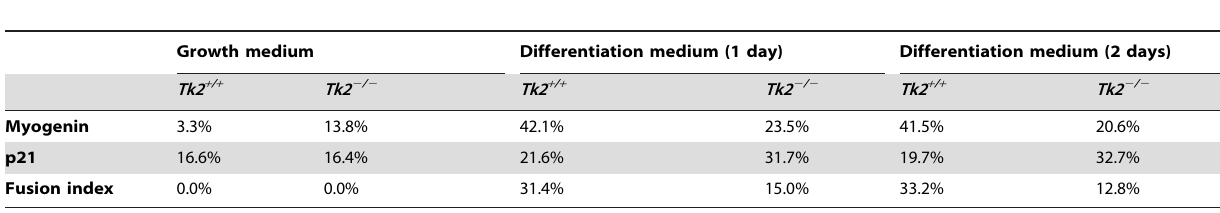
Table 3. Percentage of Tk2 + / + and Tk2 2 / 2 positive cells for myogenin and p21 and of nuclei contained within multinucleated myotubes (fusion index) in growth and differentiation